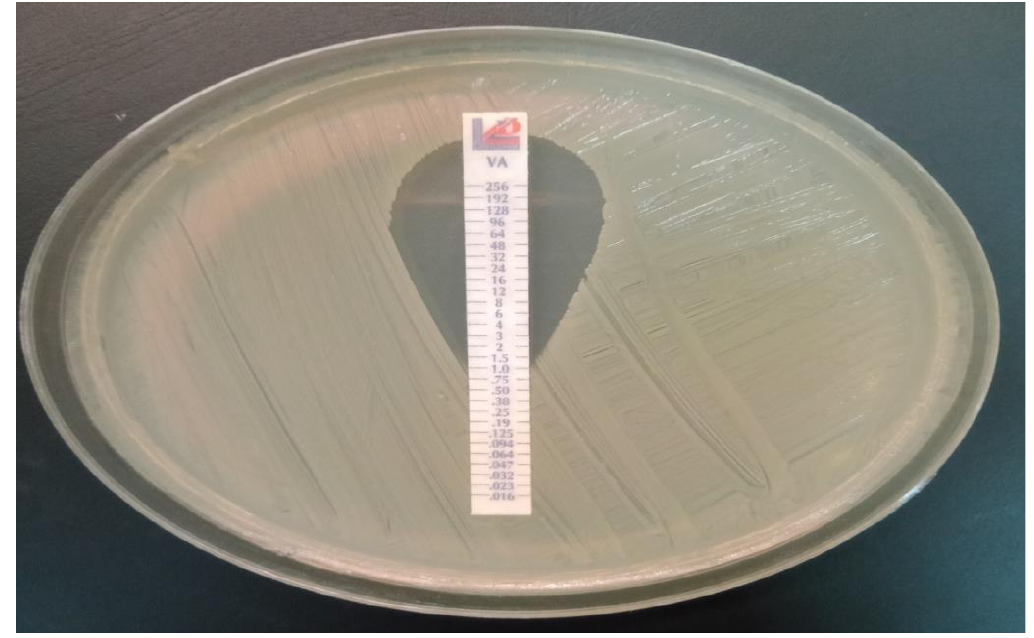
Figure 1. Testing of vancomycin susceptibility by E-test (MIC=1μg/ml).